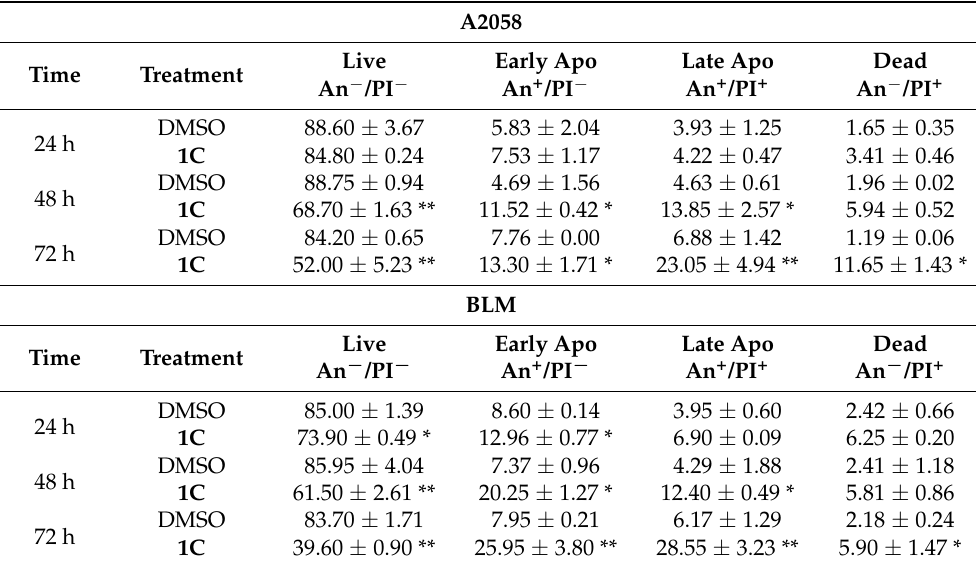
Table 4. Apoptosis analysis of A2058 and BLM melanoma cells after treatment with chalcone 1C for 24, 48 and 72 h at a concentration of 10 µ mol/L (A2058) and 20 µ mol/L (BLM).